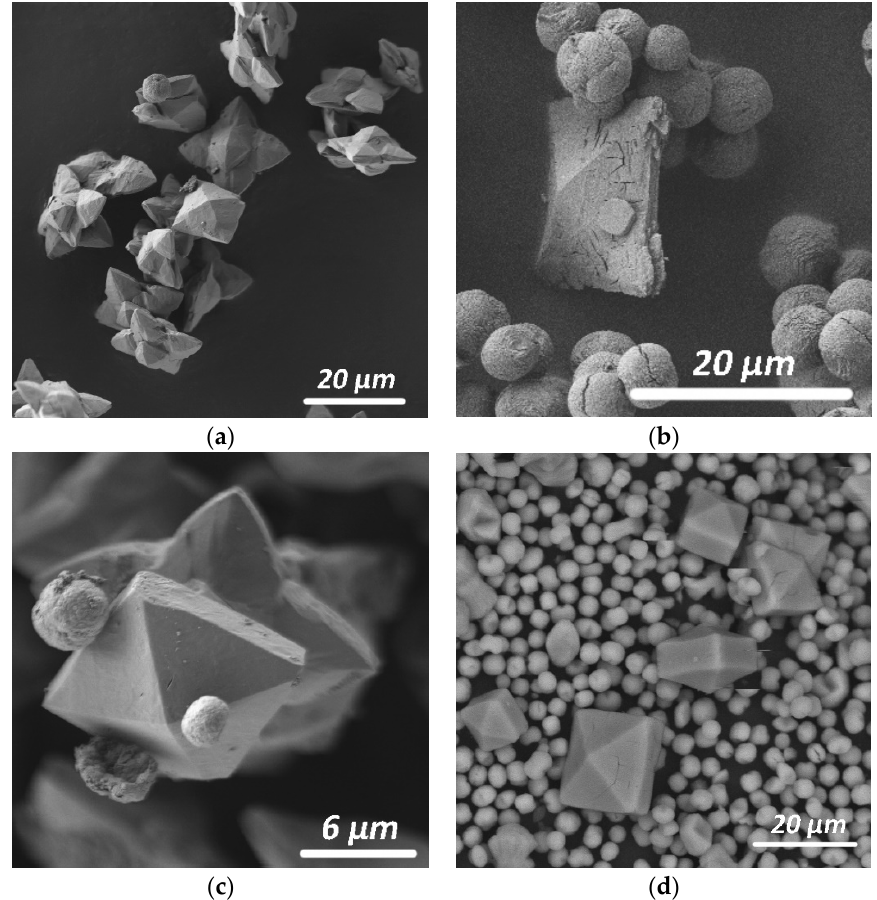
Figure 5. Tetragonal prism faces in the faceting of weddellite crystals synthesized with citrate ions and some environmental ions: ( a ) with potassium cations (Synthesis 13), ( b ) with magnesium and sulfate ions (Synthesis 23), ( c ) with carbonate ions (Synthesis 20) and ( d ) with strontium cations [24].